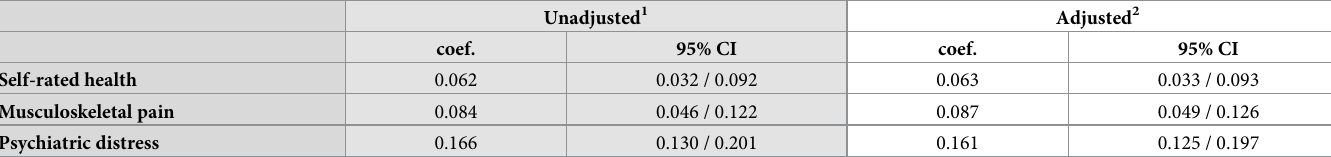
Table 1. Difference in probability for women, compared to men, to have experienced SRH, musculoskeletal pain and psychiatric